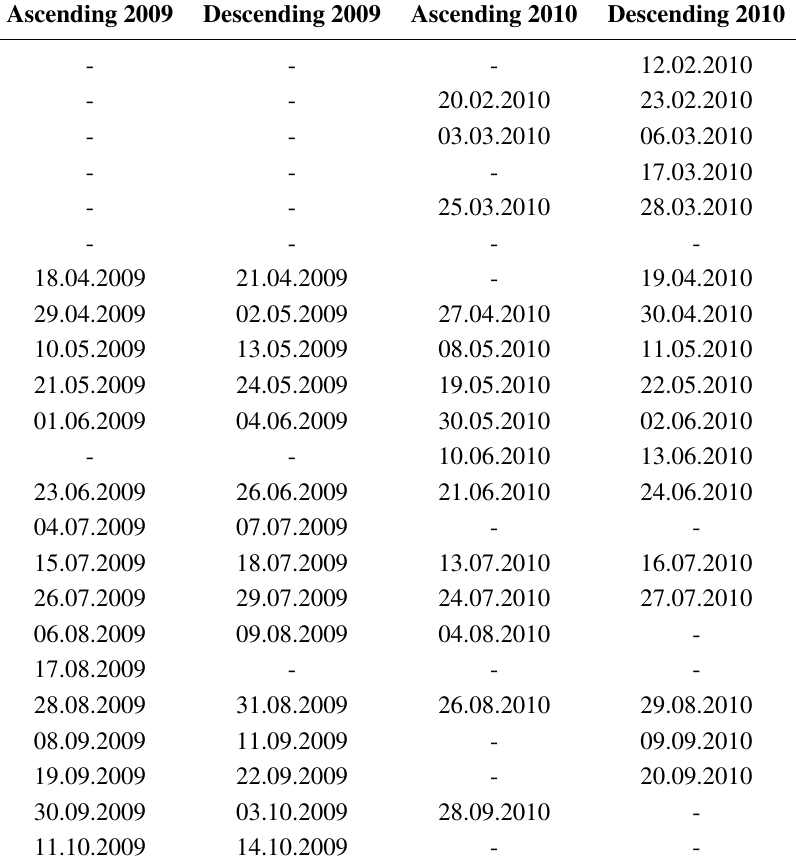
Table 1. Overview of the acquisition dates for the available ascending and descending images from 2009 and 2010. On each date, two adjacent acquisitions were taken, resulting in 124 single scenes. TerraSAR–X acquires data with a repeat cycle of 11 days; data gaps are marked with a